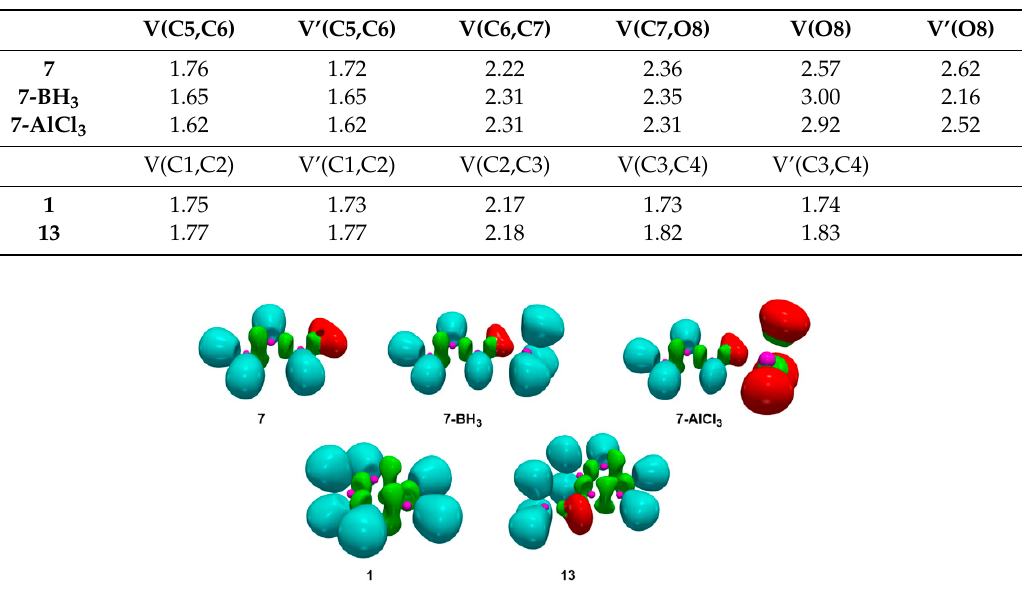
Figure 4. B3LYP / 6-31G(d) ELF localization domains, represented at an isosurface value of ELF = 0.75, of 7 , 7-BH 3 , 7-AlCl 3 , 1 , and 13 .